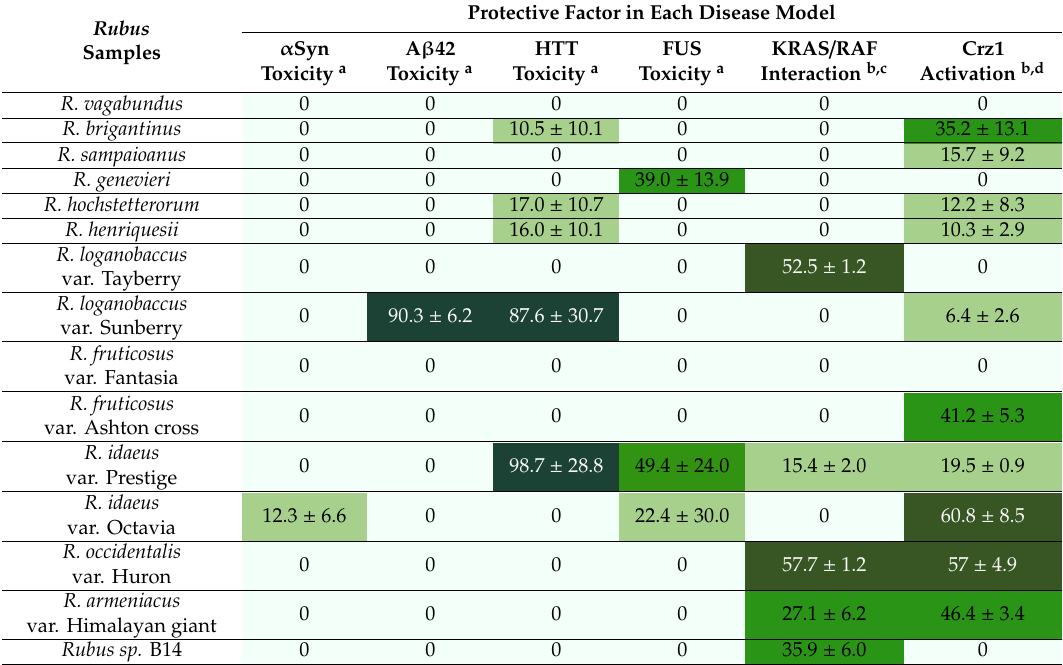
Table 1. Bioactivity of Rubus polyphenol-enriched extracts towards pathological processes of redox-related diseases as determined by the estimation of the protection